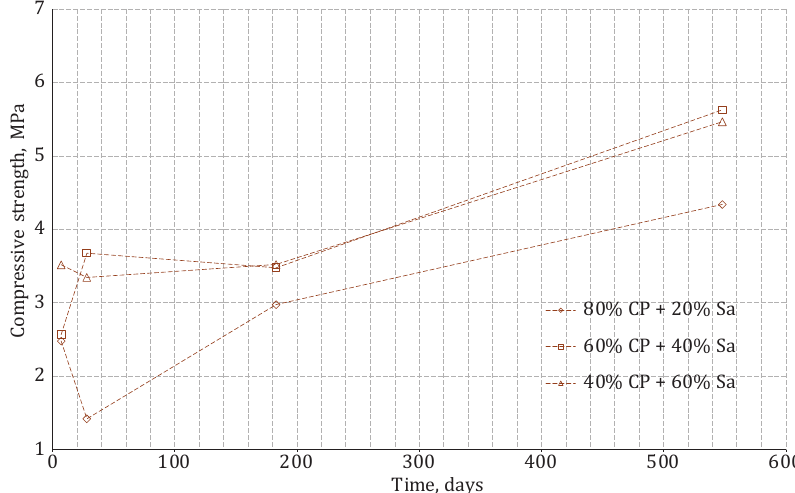
Figure 9. Updated compressive strength of samples (90% Portland cement + 10% fly ash) after Zakarka et al. (2019)